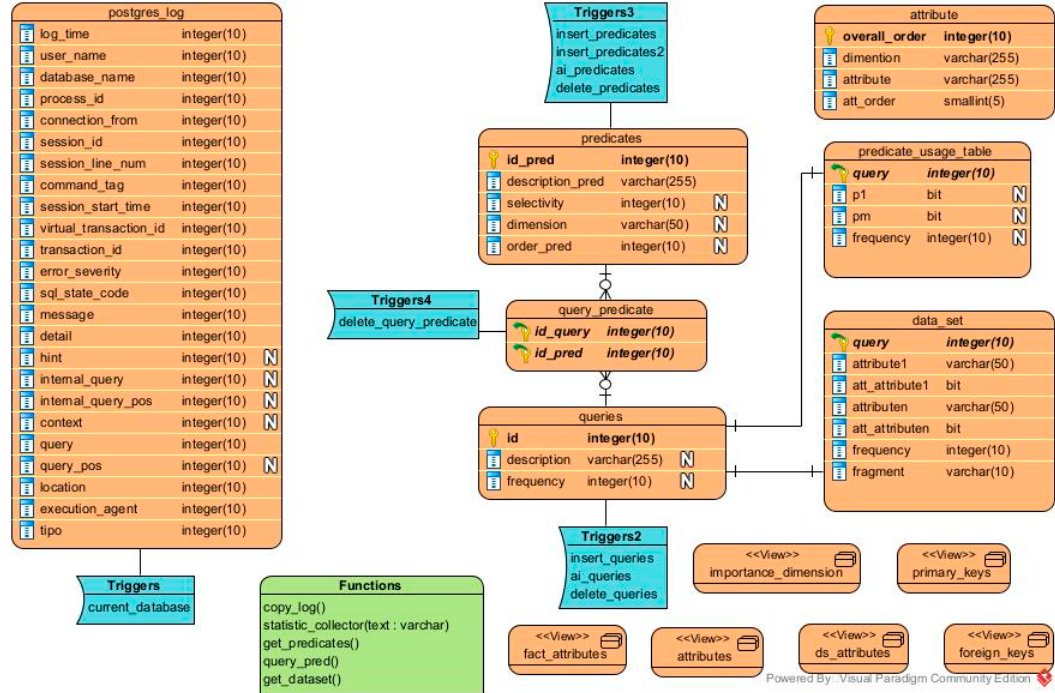
Figure 4. Physical model of the FTree schema. Table 8. Elements of the FTree schema created in the DW.